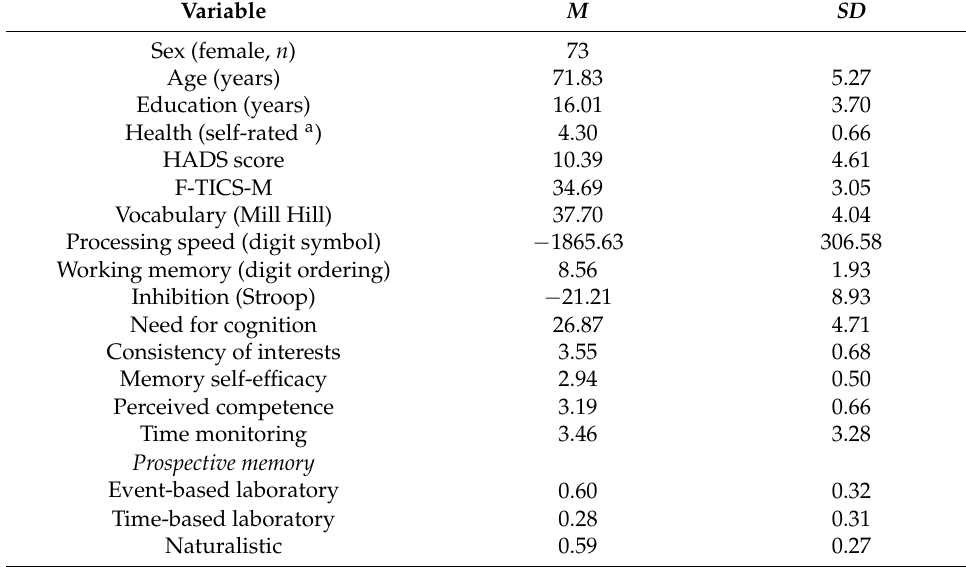
Table 1. Characteristics of the